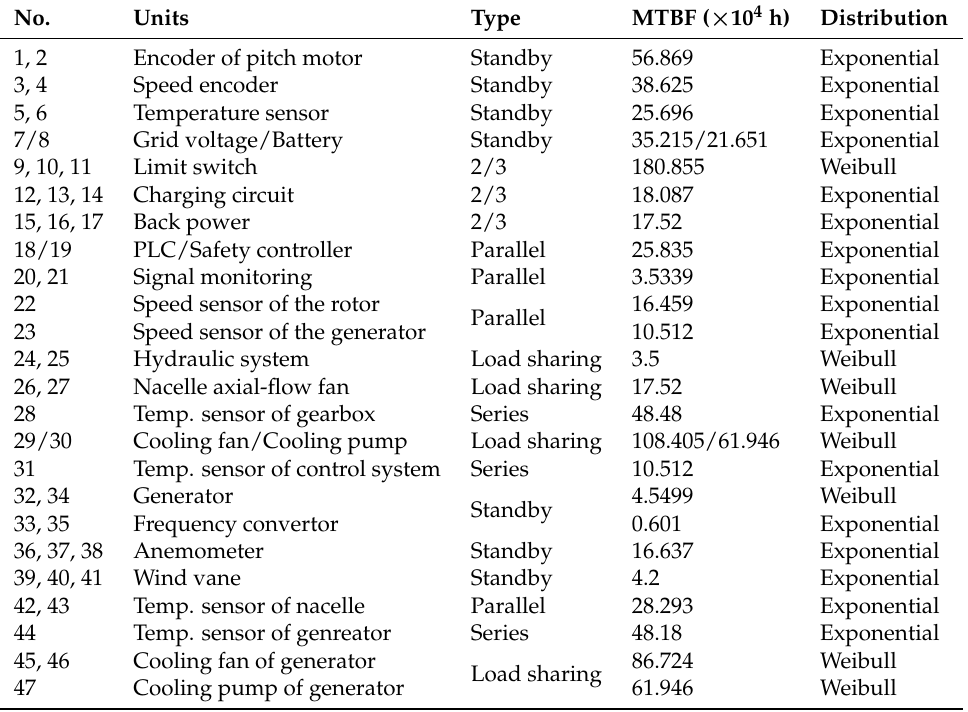
Table 2. Parameters of basic events of fault